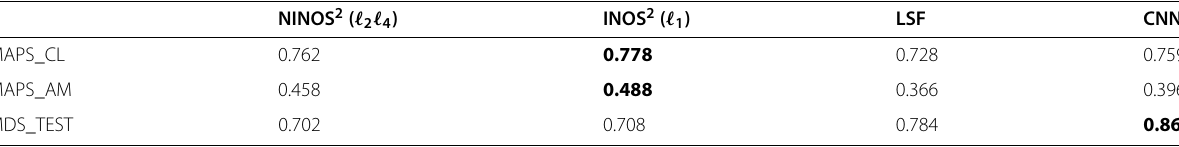
Table 6 NOD performance measures for publicly available